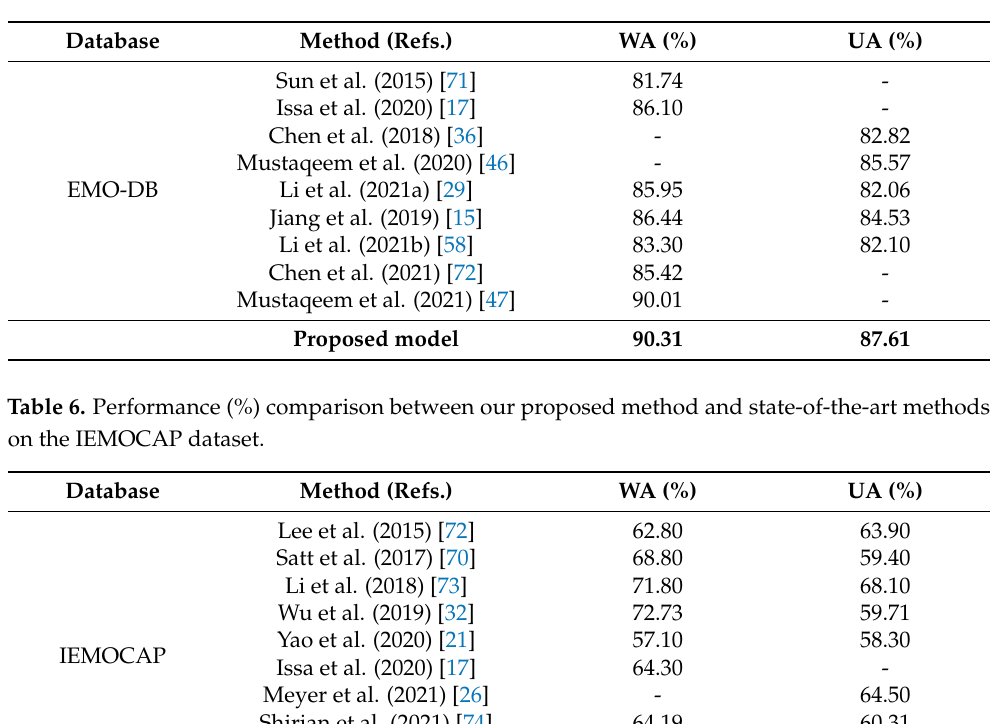
Figure 5. The confusion matrix on the SITB-OSED dataset. ( a ) The Conv-Cap module with a UA of 82.30%, ( b ) the Bi-GRU module with a UA of 83.84%, and ( c ) the proposed model with a UA of 86.19%. Table 5. Performance (%) comparison between our proposed method and state-of-the-art methods on the EMO-DB dataset.